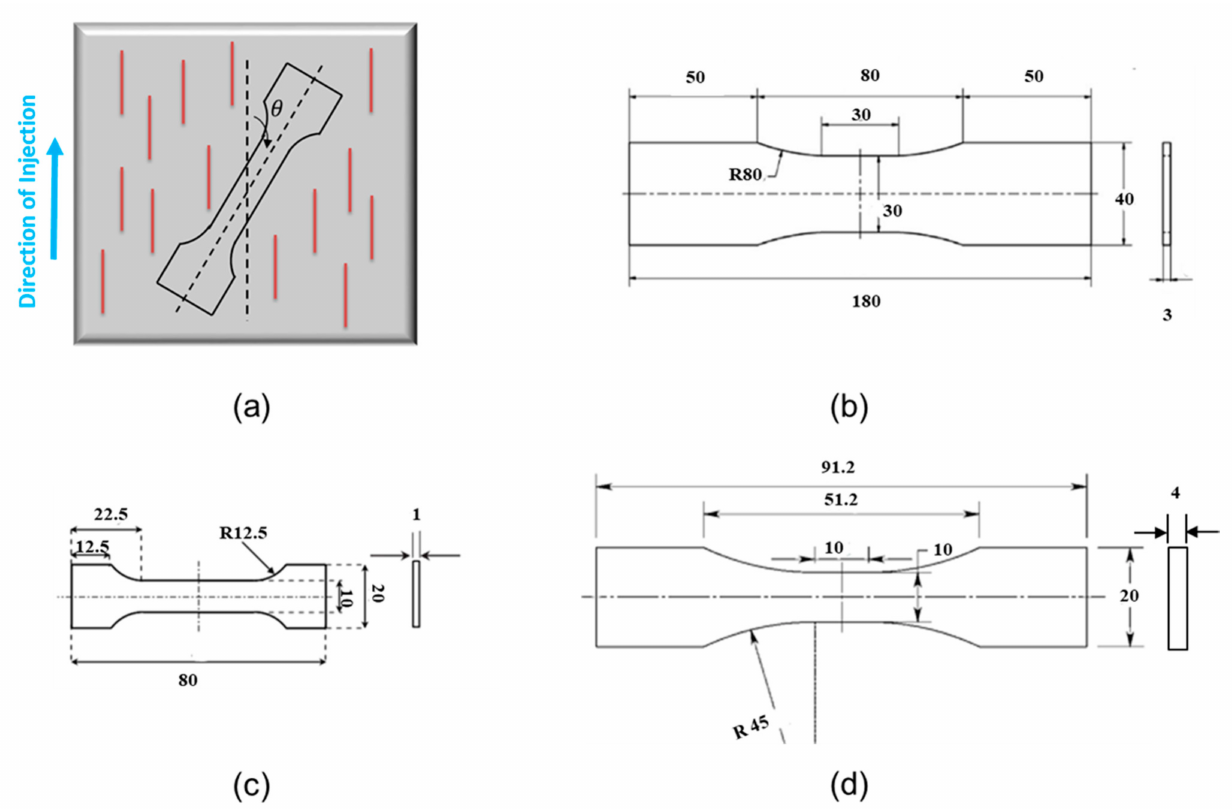
Figure 2. ( a ) Cutting the specimens with respect to injection direction ( b ) Specimen geometry used for uniaxial fatigue testing for PBT + PET-30GF from [9]. ( c ) Specimen geometry used for uniaxial fatigue testing for PA66-35GF from [18]. ( d ) Specimen geometry used for uniaxial fatigue testing for PP-30GF, PA66-30GF (Polyamide 66 + 30% Glass Fiber), PBT-35GF, and PA6-35GF from